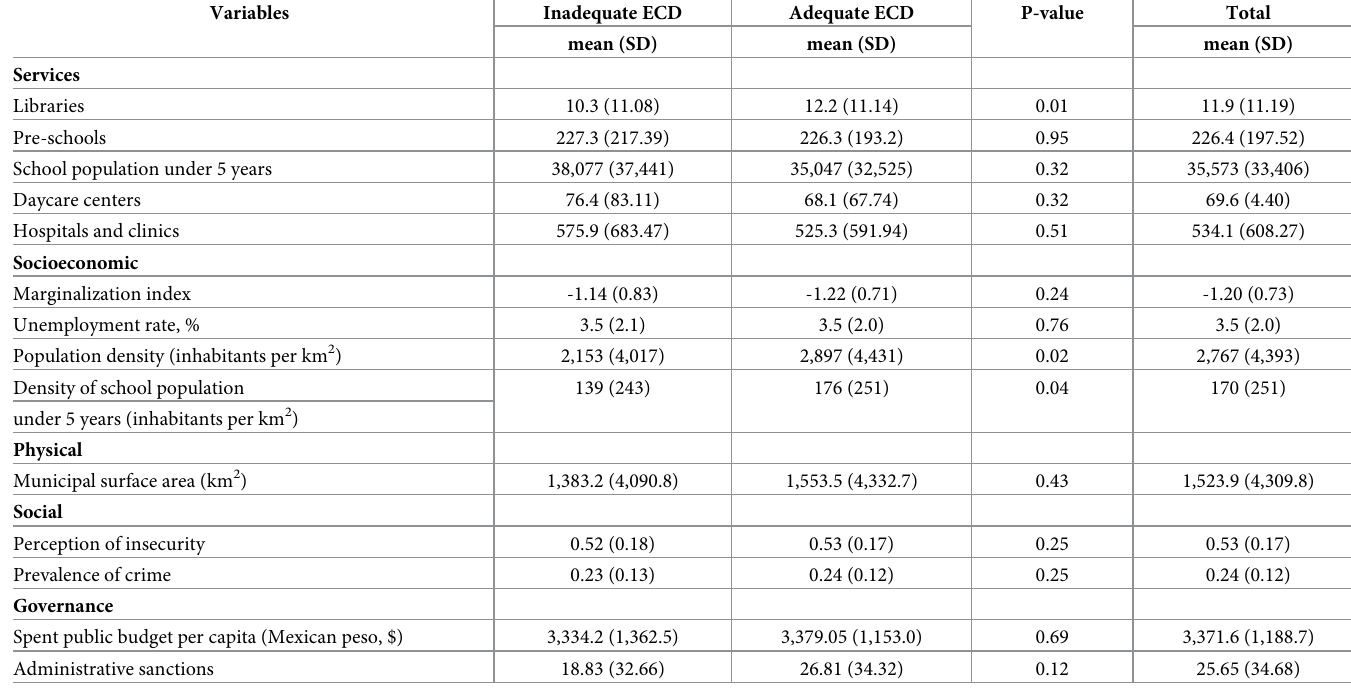
Table 3. Neighborhood characteristics for the municipalities of children with inadequate or adequate early childhood development in the